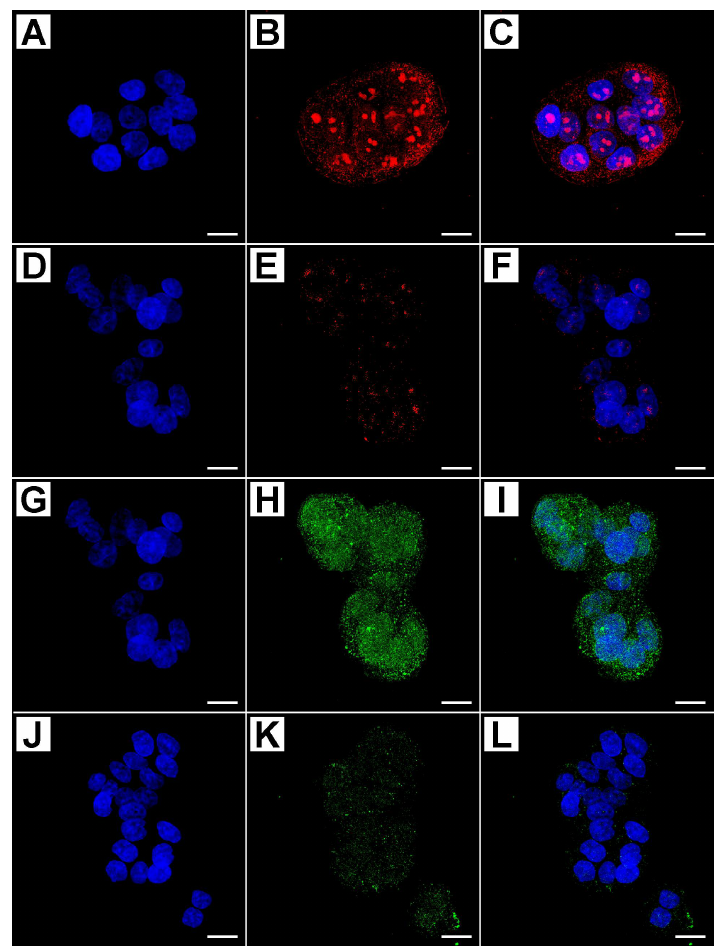
Figure 4. Confocal analysis of APAF-1 and MAPLC3 proteins in treated and untreated cells with different concentrations of metformin (Blue: DAPI; Green: MAPLC3; Red: APAF-1; ( C , F , I , L ): merge). In treated cells with 50 mM MET for 48 h, APAF-1 showed a diffuse or granular staining pattern at the nuclear level ( A – C ), while in untreated cells nuclear expression was barely detectable ( D – F ). In treated cells with 50 mM MET for 48 h MAPLC3 protein there were two distinct autophagic patterns: A diffuse finely and granular reactivity dispersed in the cytoplasm, or a rounded densely stained material, probably enclosed within a cytoplasmic vacuole that accumulates prevalently around the nucleus ( G – I ); untreated cells were very weakly marked ( J – L ). Scale bar = 10 µm.